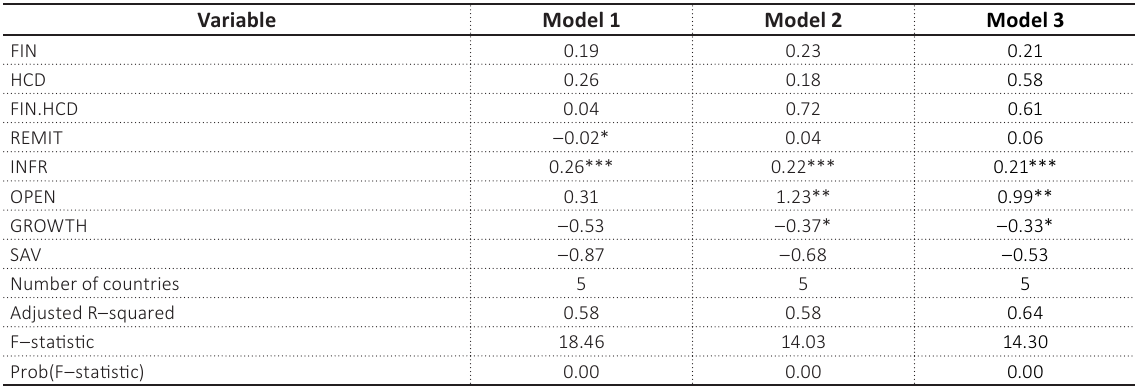
Table 6. Financial sector development and FDI inflows – Fixed effects